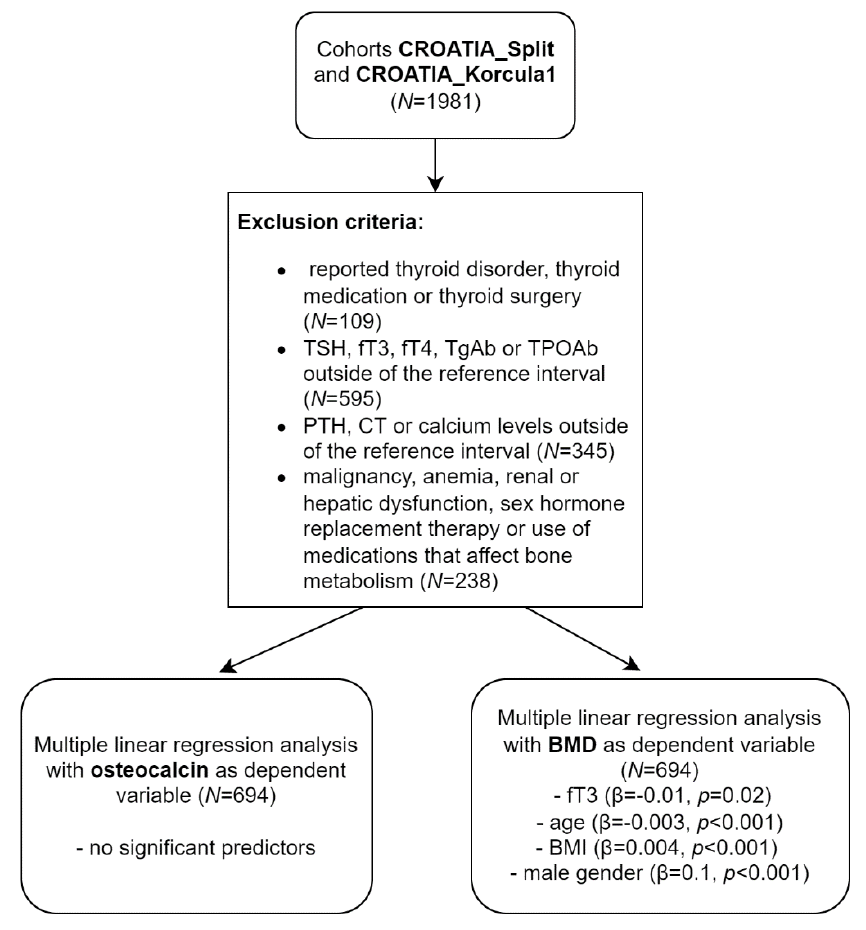
Figure 1. Exclusion criteria to define population and results of linear regression analyses.